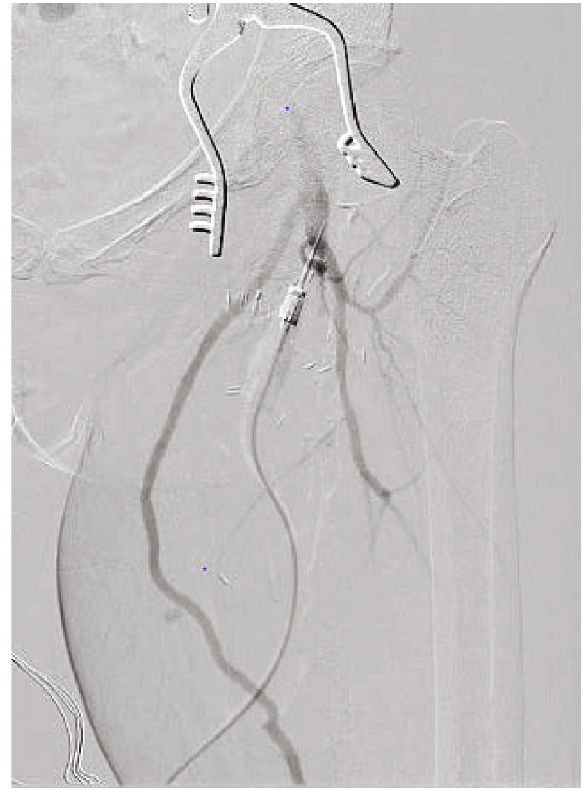
Figure 3: Diagnostic angiogram showing extra-anatomic bypass.